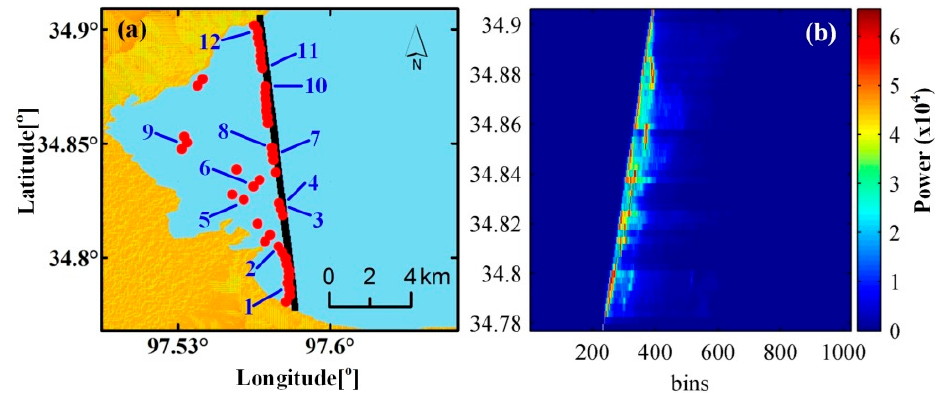
Figure 3. ( a ) Track over Ngoring Lake on 5 June 2011 (black and red solid points represent nadir and corresponding Level-2 positions of all observations, respectively), and ( b ) corresponding waveforms.